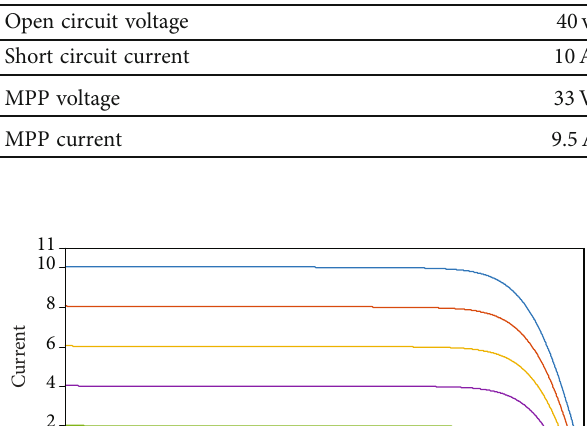
Table 1: Simulated panel characteristic.